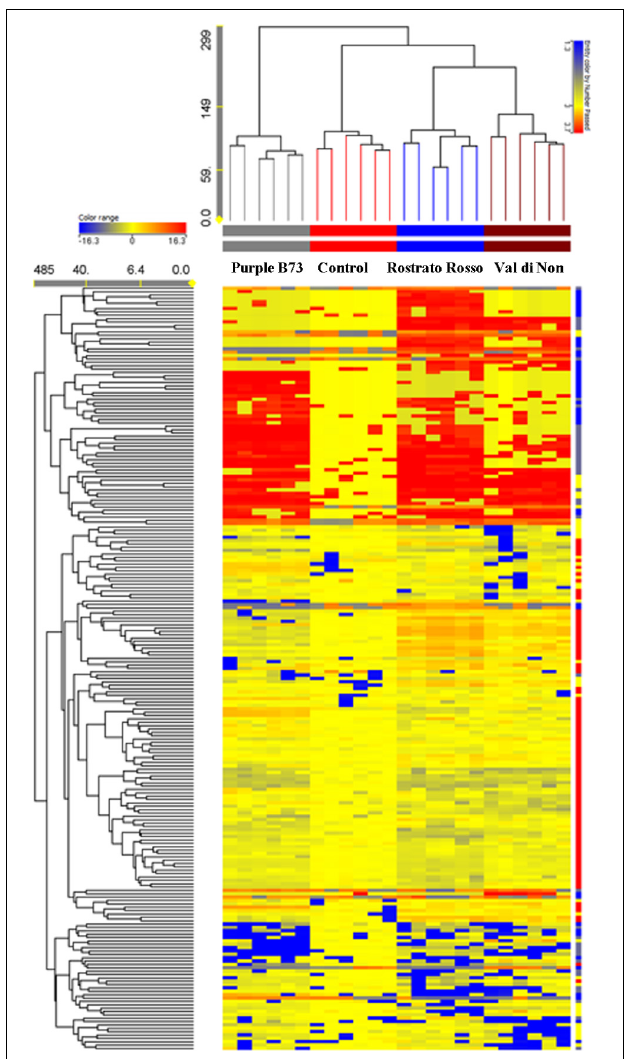
FIGURE 2 | Not averaged unsupervised hierarchical clustering on the phenolic profile of maize samples (similarity: Euclidean; linkage rule: Ward). Compounds’ intensity was used to build up fold-change based heat map, on the bases of which clusters analysis was done. Agrister was used as a non-pigmented kernel control.